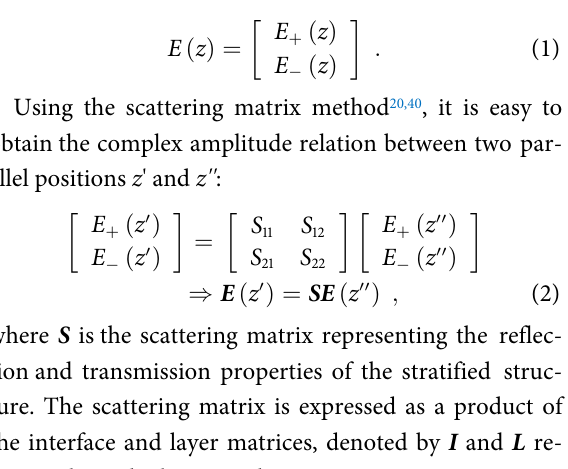
Fig. 1 | ( a ) Schematic diagram of the investigated F-P cavity-based displacement transducer located in air. ( b ) Low-case of the stratified system. ( c ) Up-case of the stratified